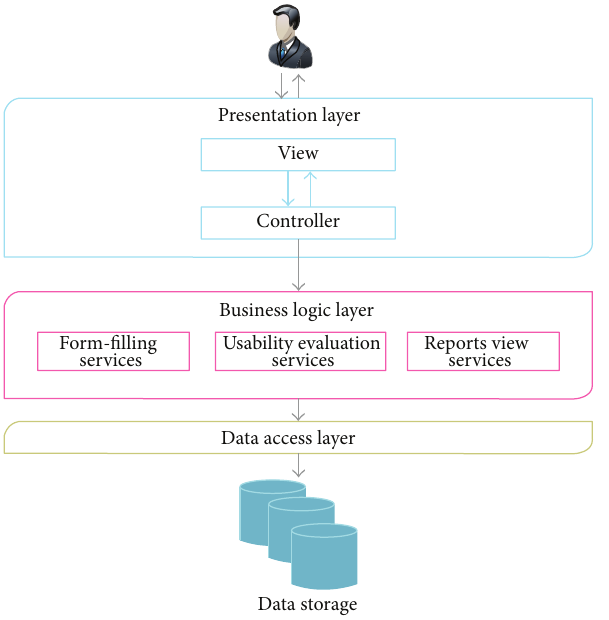
Figure 1: A high-level architectural design of the IUE